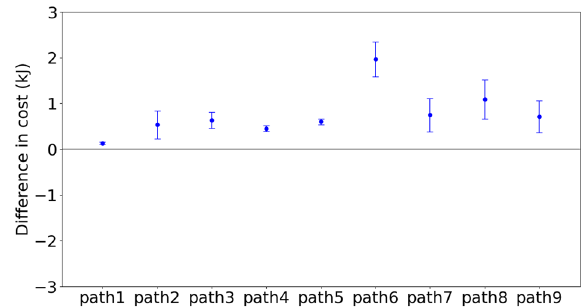
Figure 5. The difference in the energetic cost for the model perturbation. The figure shows the difference in the energetic cost of tracing each of the nine paths with perturbations in the right-elbow marker. The elbow was moved up 5cm. The results show that the original path is always the least expensive for all the paths and the averages across subject tracers. Moreover, the differences between the energetic costs of original trajectories and perturbed trajectories are highly significant, with a p-value less than 0.001.